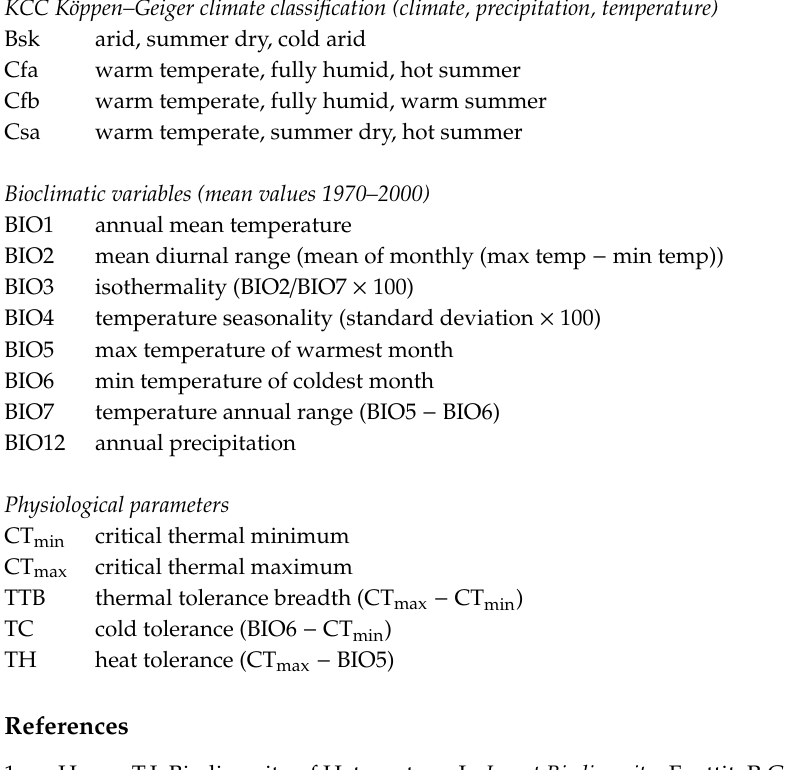
Figure S1: Theoretical cladogram. Figure S2: Correlation of CT min and CT max with fresh body mass. Figure S3: Correlation of physiological parameters with bioclimatic variables. Table S1: Species, sample date, sample location, KCC, and bioclimatic parameters of the true bugs assessed. Table S2: Statistical